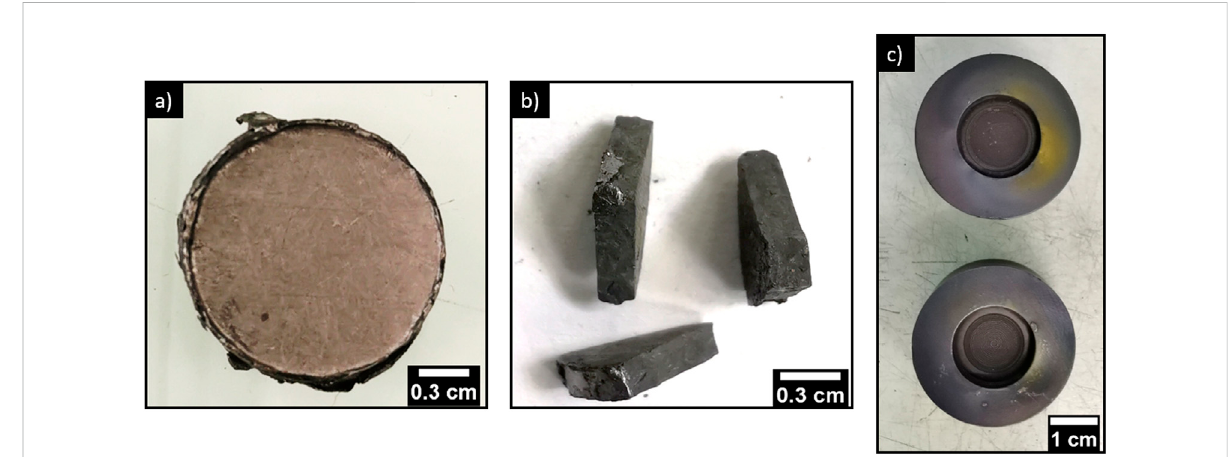
FIGURE 6 Matrix obtained after SPS conversion of iodine-loaded sorbents calcined at 350 ° C (A) in front view and (B) in slice view. (C) Graphite tools used after the sorbents conversion.